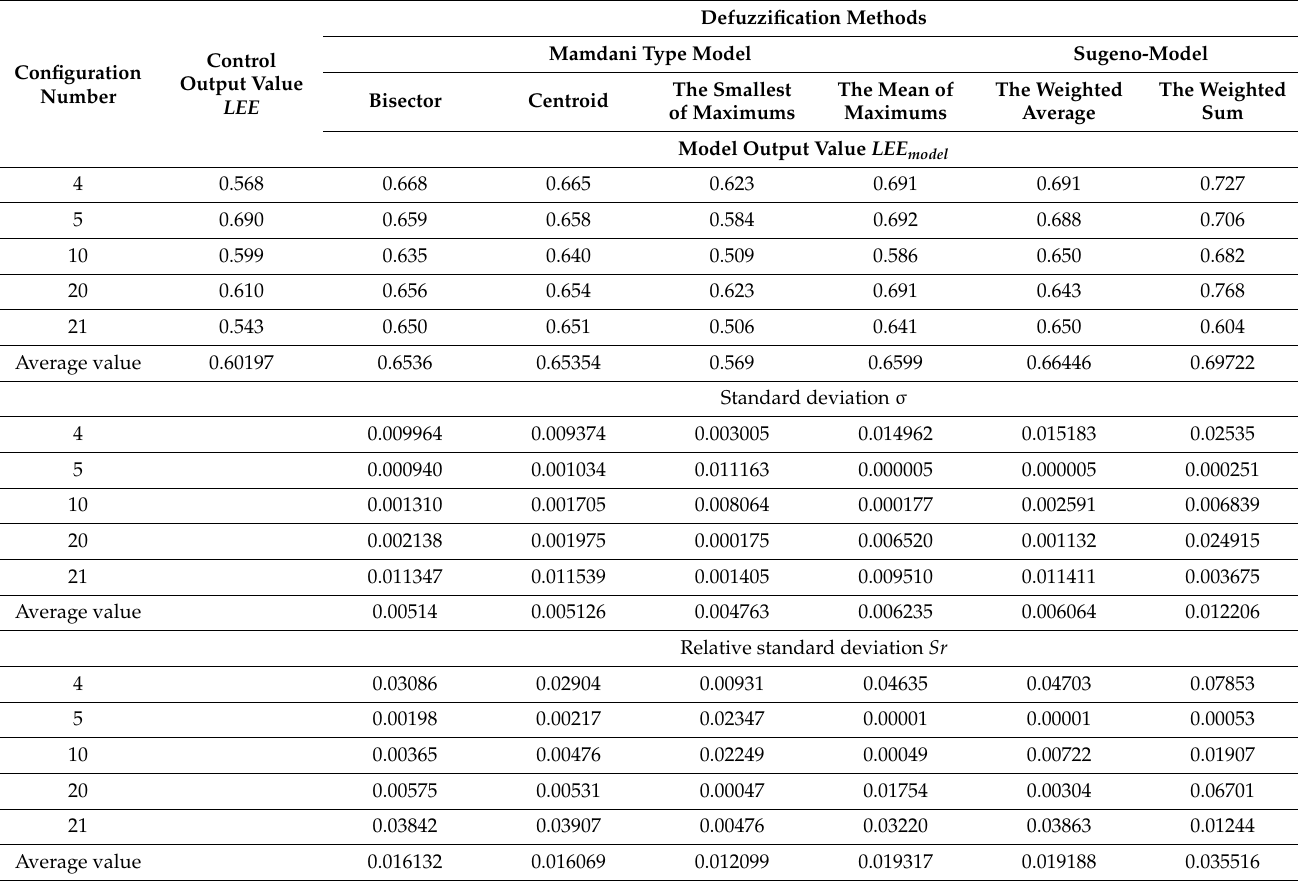
Table 5. Simulation results using different defuzzification algorithms.